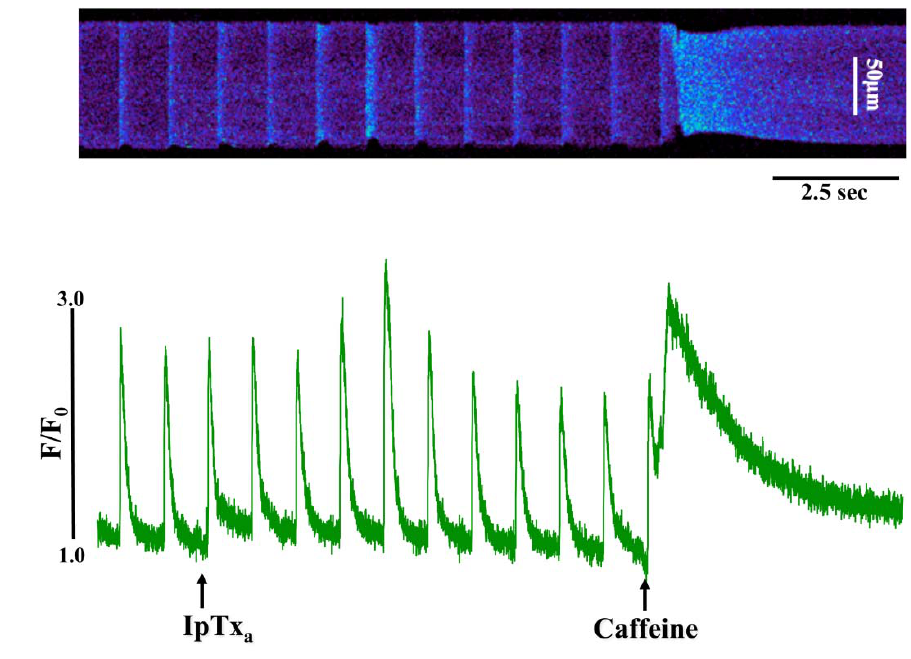
transients. Line-scan image (top) and associated fluorescence plot (bottom) of a field- stimulated mouse ventricular cardiomyocyte loaded with the Ca 2+ indicator Fluo-4